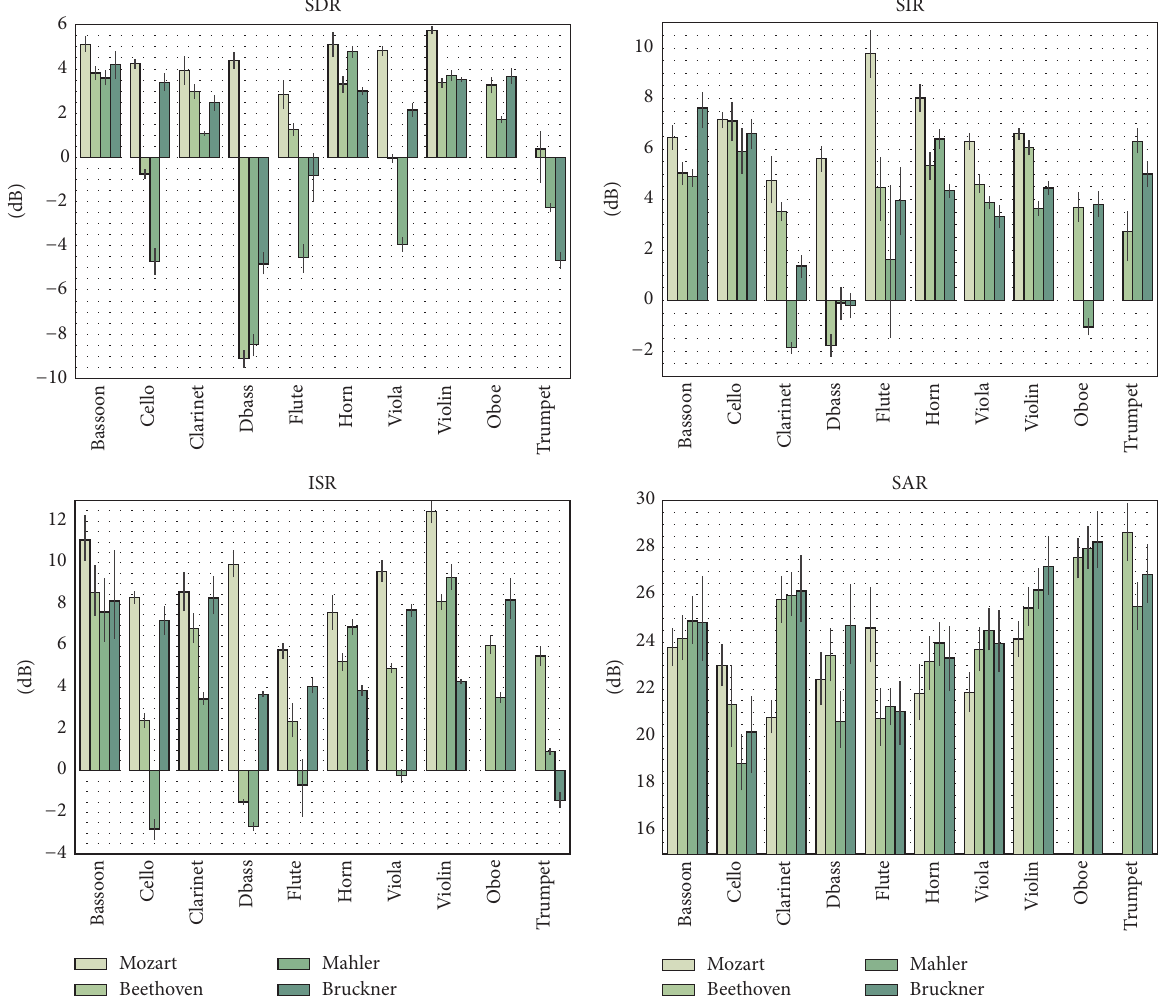
Figure 6: Results in terms of SDR, SIR, SAR, and ISR for the instruments and the songs in the dataset.